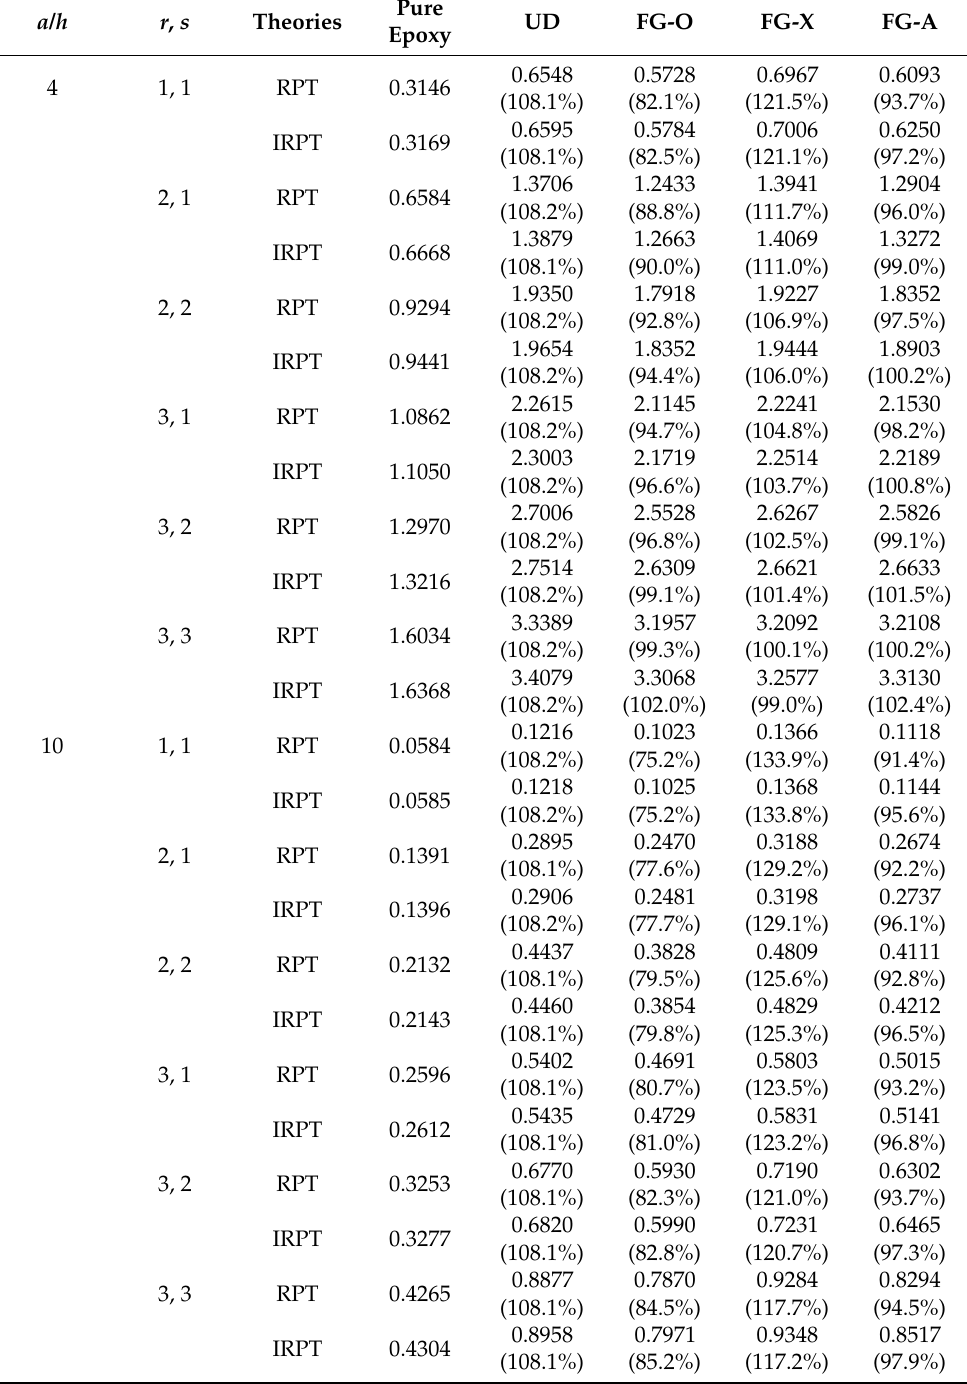
Table 4. Dimensionless natural frequencies of pure epoxy square plates and FG-GRC square plates with various mode shapes. ( N L = 10, f G =